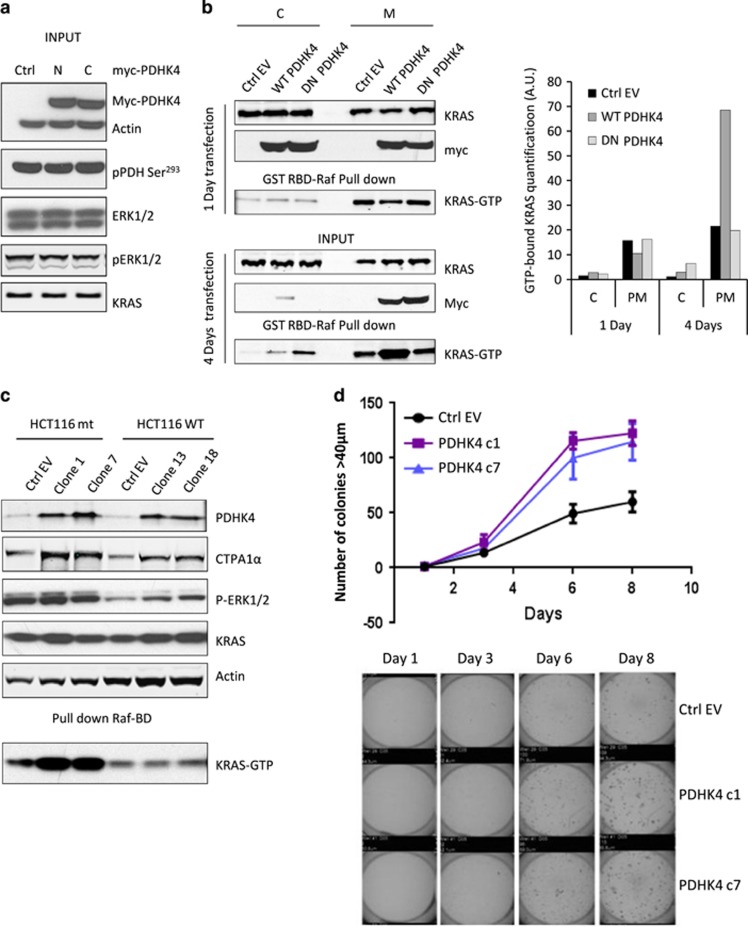
Stable PDHK4 expression enhances mutant KRAS activity in the plasma membrane and induces in vitro cell growth in 3D cultures. (a) HCT-116 cells were transiently transfected for 24 h with two full length constructs of PDHK4 (1 μg), either N- or C-terminally labelled with a myc-tag (3 μg). Western blotting was carried out to determine which construct gave the best expression levels. (b) HCT116 cells were transfected with the PDHK4 full-length (1 μg) and dominant negative (DN, 3 μg) C-terminal myc tag constructs for 1 and 4 days followed by cell fractionation. Each fraction was subjected to immunoblot and KRAS GTPase pull-down assay to detect activity. Chart represents the quantification of GTP-bound KRAS in the cytoplasmic and membrane fractions normalized to total KRAS levels. (c) PDHK4 stable clones were generated with the full-length PDHK4 C-terminally myc-tag construct in HCT116 KRAS WT (clones 13 and 18) and mutant (clones 1 and 7). Protein extracts were subjected to KRAS GTPase pull-down assays and expression levels of indicated proteins including KRAS-GTP bound were verified by western blot. (d) KRAS mutant PDHK4 clones 1, 7 and empty vector (EV) were suspended into 0.3% agarose and plated on a 1% agar bottom layer. Colonies>40 μm were counted using a Gelcount scanner every 2 days for 2 weeks. Error bars represent the ±s.e.m of replicates (n=5).